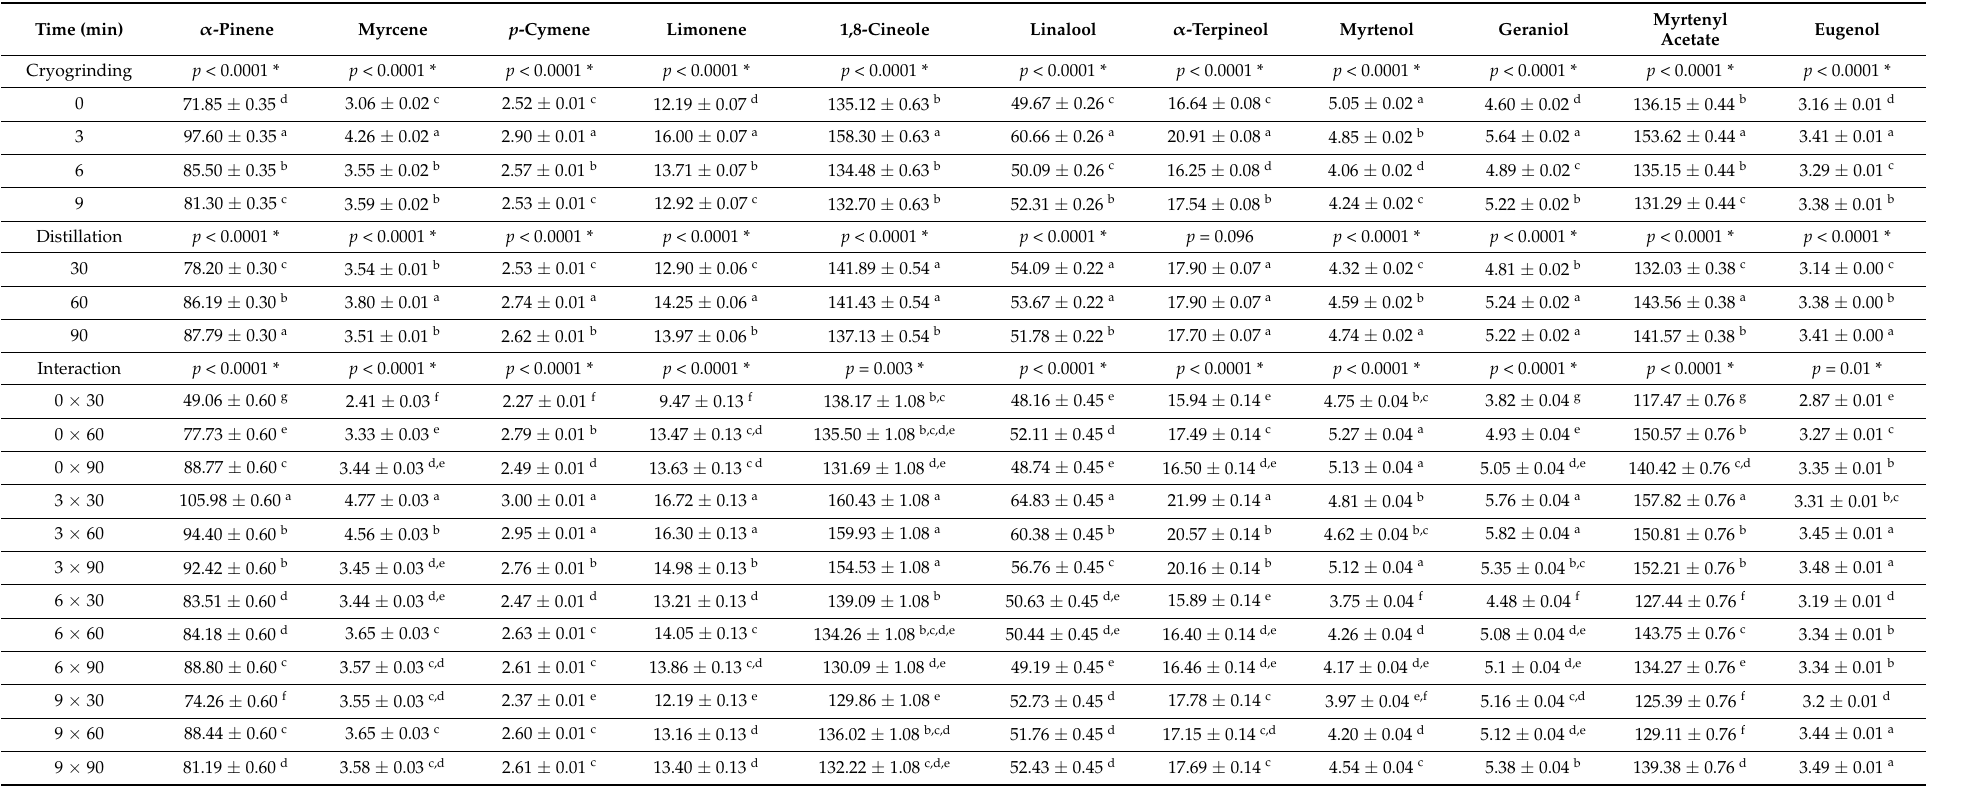
Table 1. Profile of myrtle leaf EO (mg/100 g dw) obtained by different CG and extraction